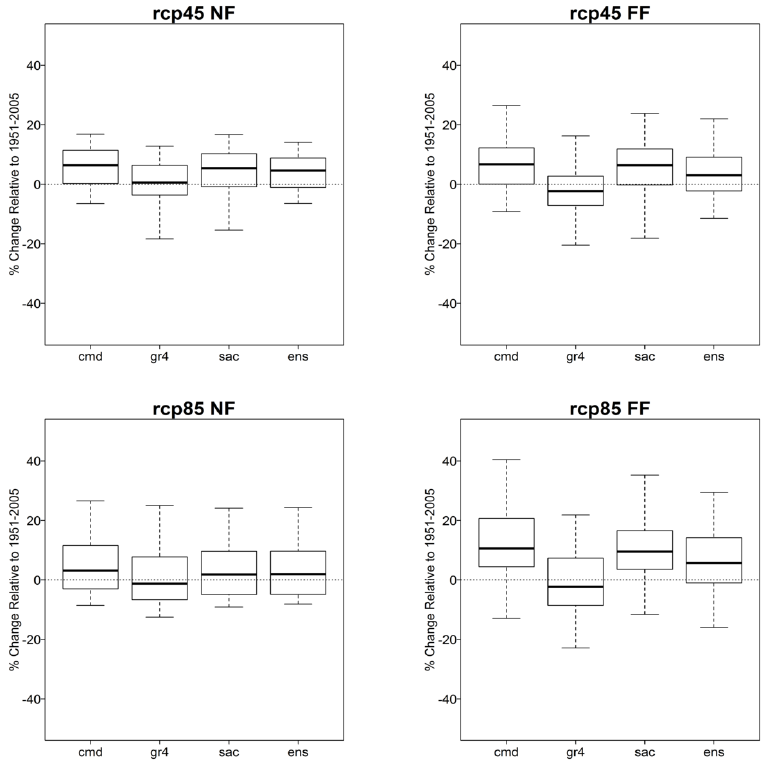
Figure 6. Effect of model structure uncertainty on climatological trends of the ensemble mean projected runoff at the Near Future (NF: 2010–2035) and Far Future (FF: 2036–2099).